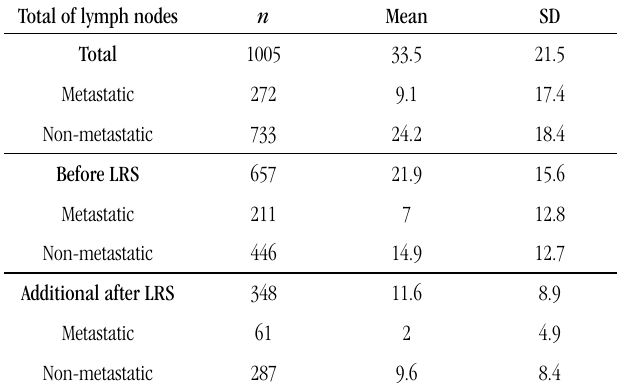
tABLE 1 − Number of lymph nodes (metastatic and non-metastatic) before and after exposure to